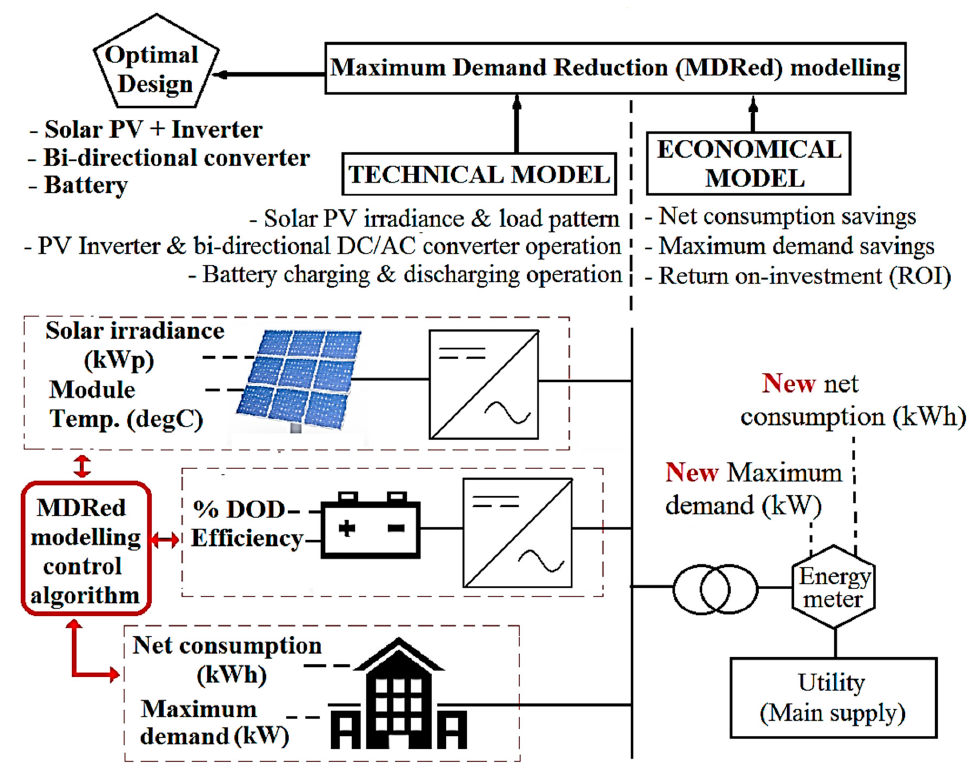
Figure 2. Maximum demand reduction (MDRed) modeling approach.